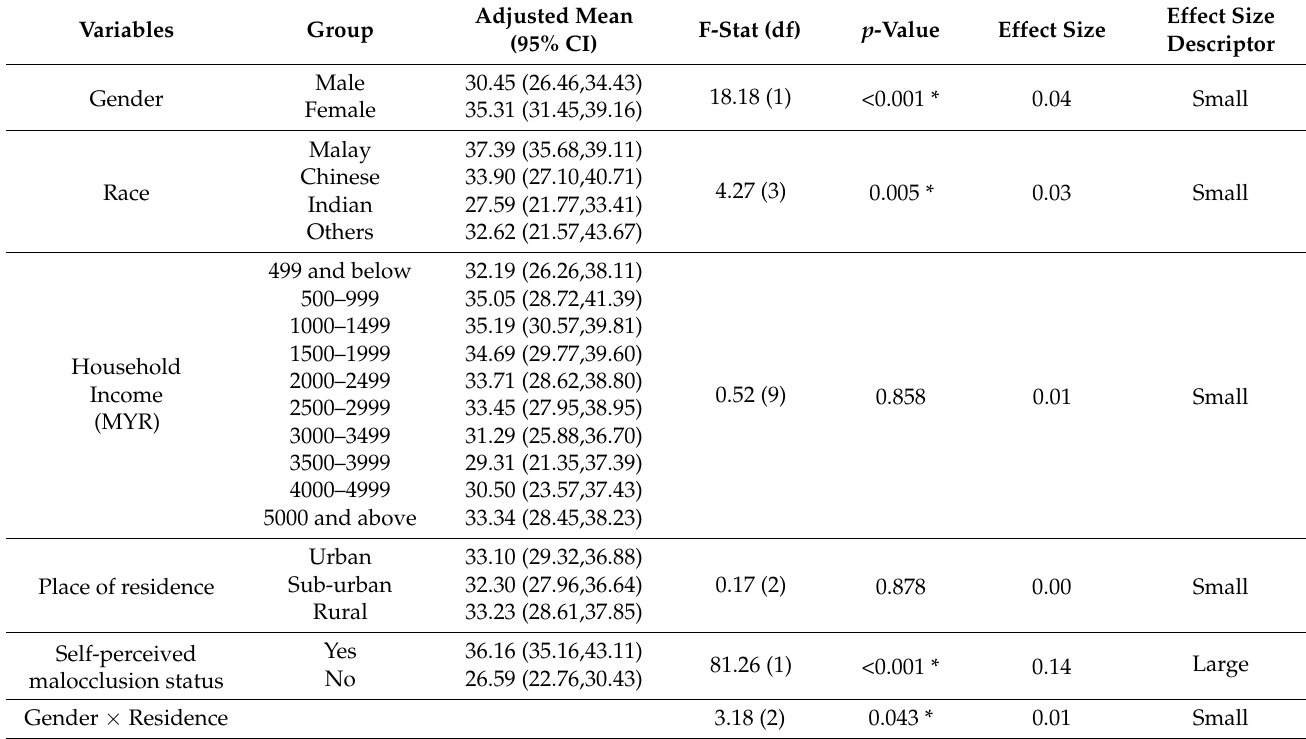
Table 5. Association between significant factors and total PIDA scores by multifactorial ANOVA analysis ( N = 524).